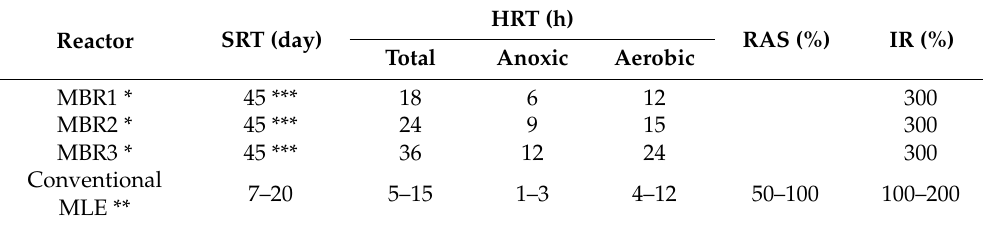
Table 1. Operation parameters.